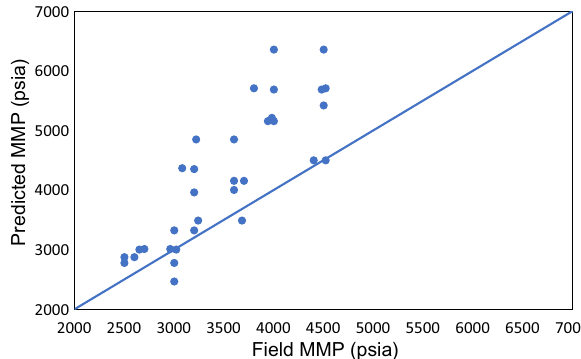
Fig. 4 Cross-plot of MMP training data for Glaso (1985)